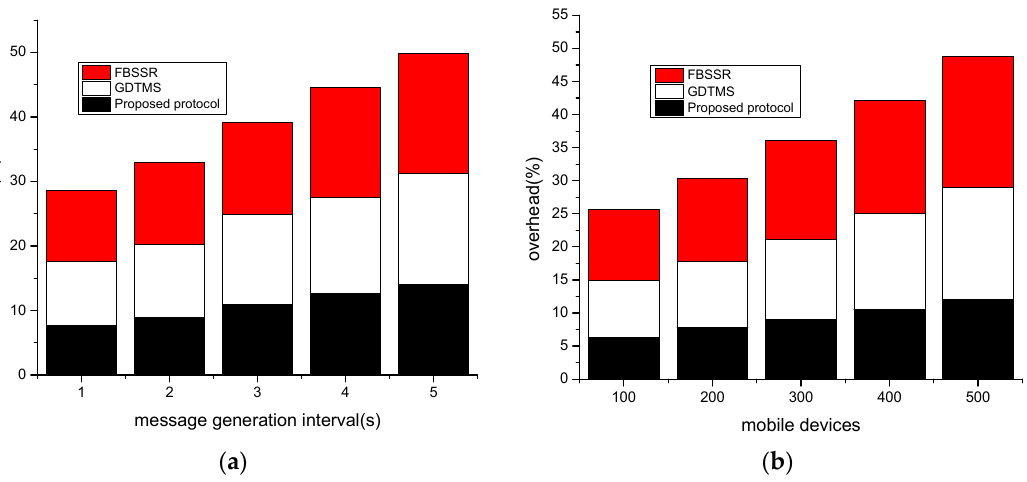
Figure 6. ( a ) Overhead with message generation interval. ( b ) Overhead with mobile devices.